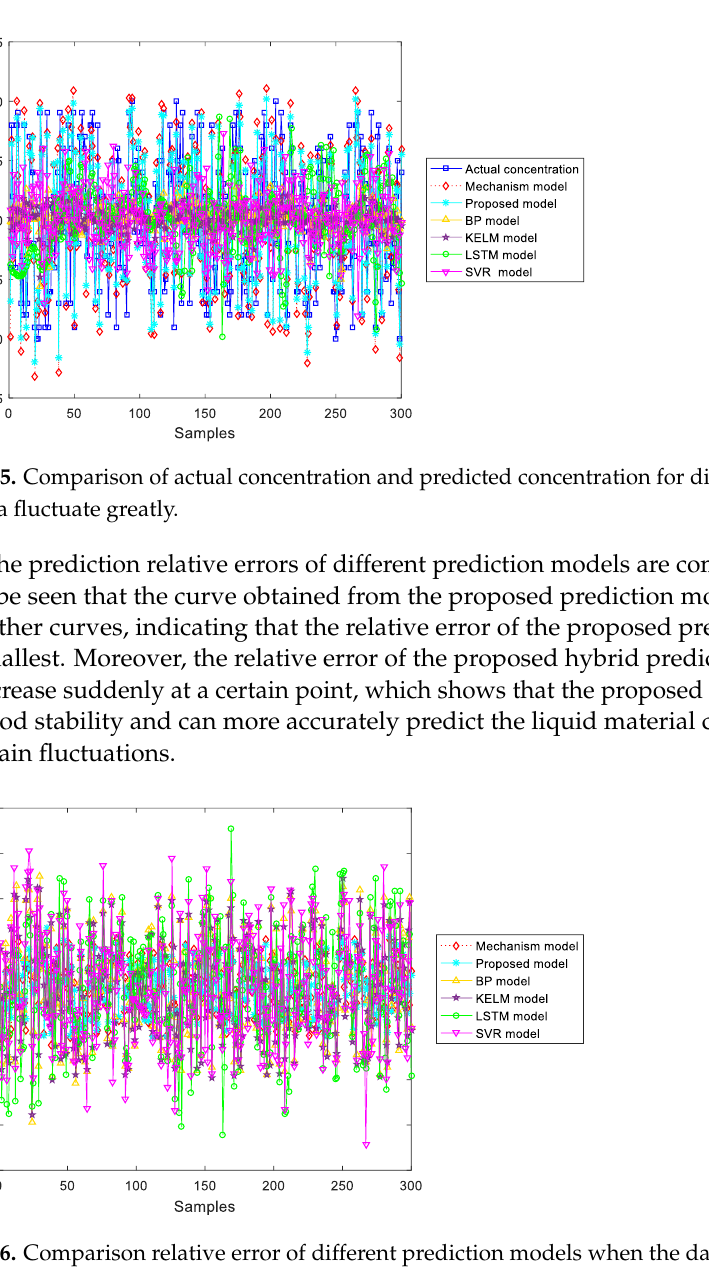
Figure 6. Comparison relative error of different prediction models when the data fluctuate greatly.